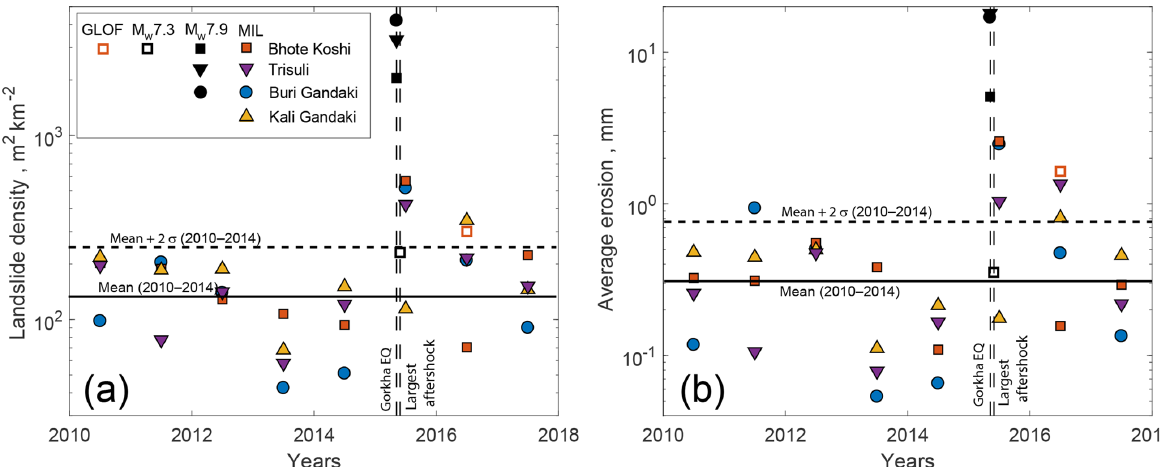
Figure 2. Landslide density (a) and average erosion (b) associated with the 2010–2017 monsoons in RapidEye mapping areas BG, BK, T and KG. Large landslides in KG (2013 and 2015) and BK (2014) have been removed (see text for details). Solid black squares represent the coseismic landsliding due to the Gorkha earthquake (EQ) in BK, BG and T, while open black squares represent the landslides induced by the 12 May 2015 aftershock in the BK valley. Open orange squares indicate the 2016 BK landsliding including bank collapses that are mostly due to a glacier lake outburst flood (GLOF) in that year (Cook et al., 2018). The solid and dashed black lines in (a) and (b) are the mean values of all catchments and the mean + 2 σ from 2010 to 2014. Volume conversion leads to 1 σ uncertainties between 5% and 30% of the total average erosion volume, which is relatively small compared to the data